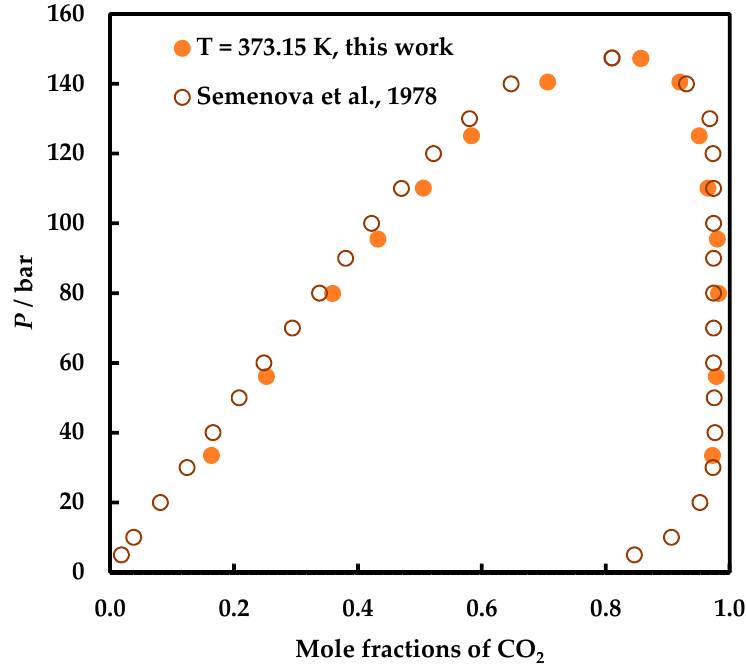
Figure 1. Comparison of measured and literature data [26] for carbon dioxide (1) + isobutanol (2) system at 373.15 K. Table 4. Mole fraction of component 1 in the liquid phase, X 1 , and mole fraction of component 1 in